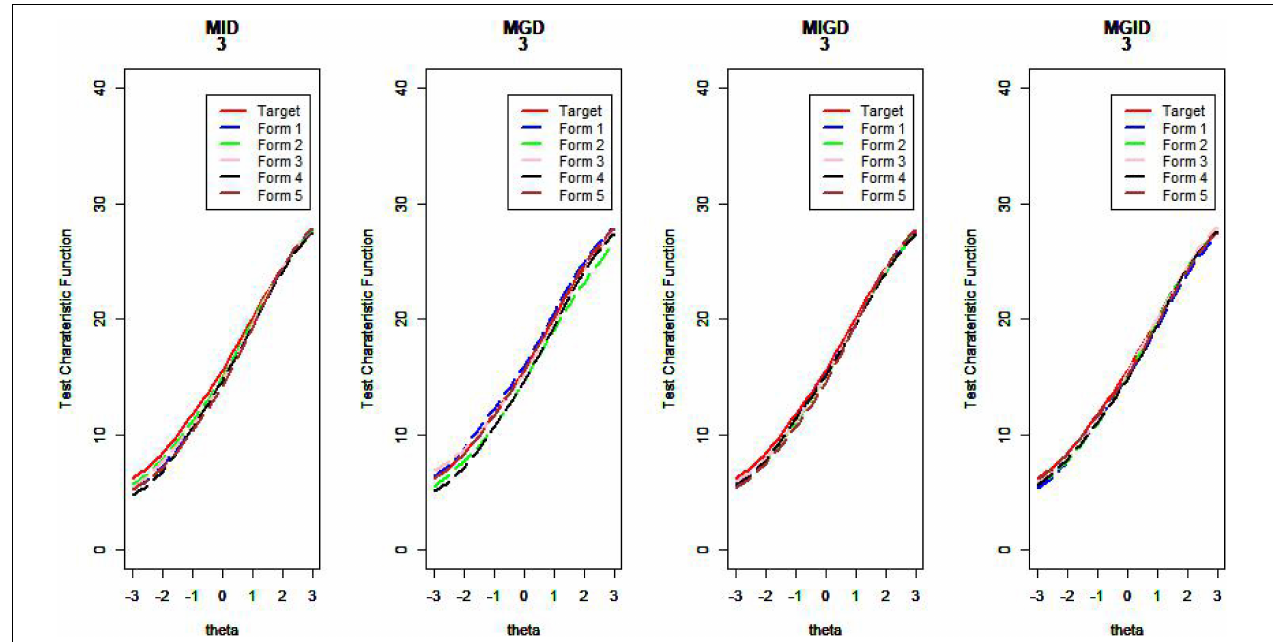
FIGURE 17 | Test characteristic curve ( D =